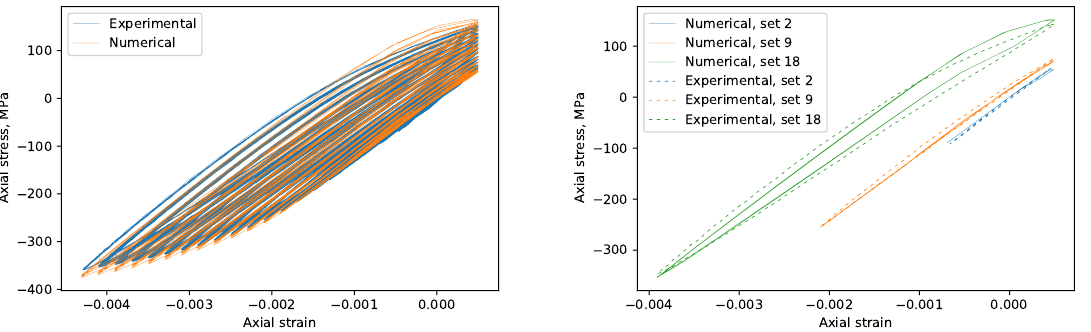
Figure 14. Stress–strain loops for the numerical model under steadily increasing applied strains. Full picture ( left ), separate loading sets ( right